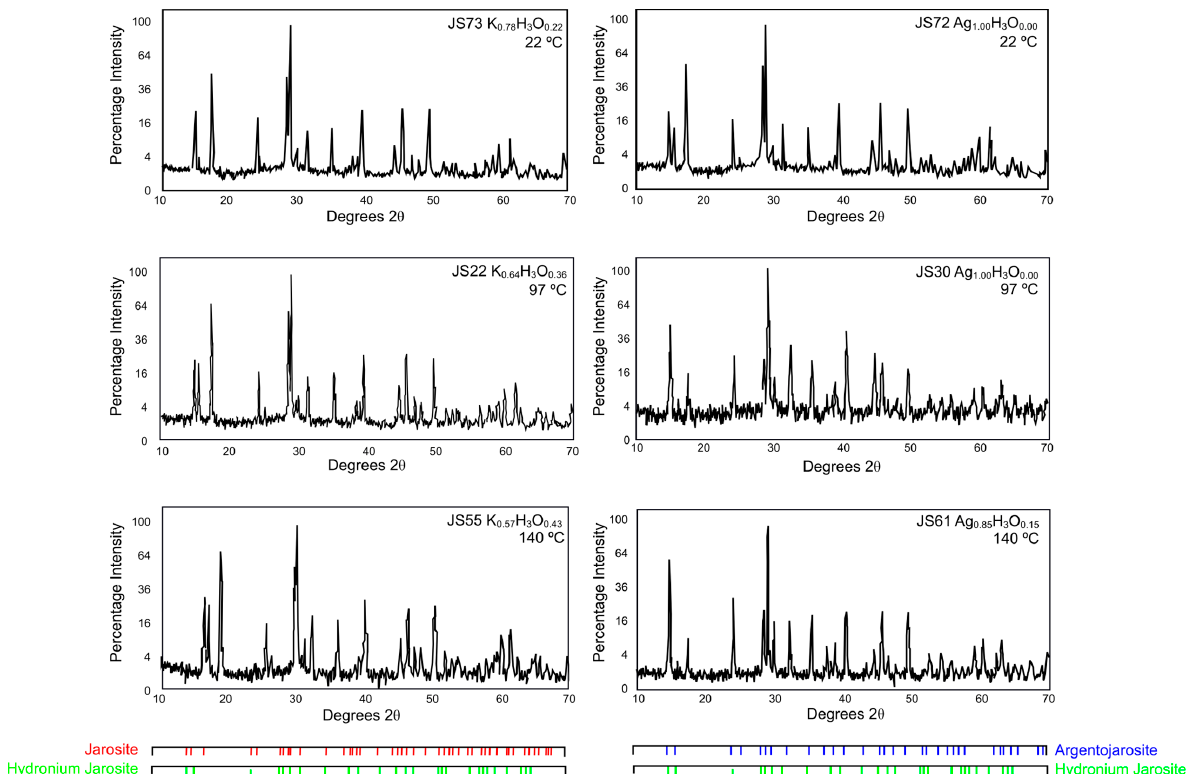
Figure 3. XRD diffractograms of synthetic end-member K-Ag-H 3 O jarosite compounds at 22 °C, 97 °C and 140 °C.